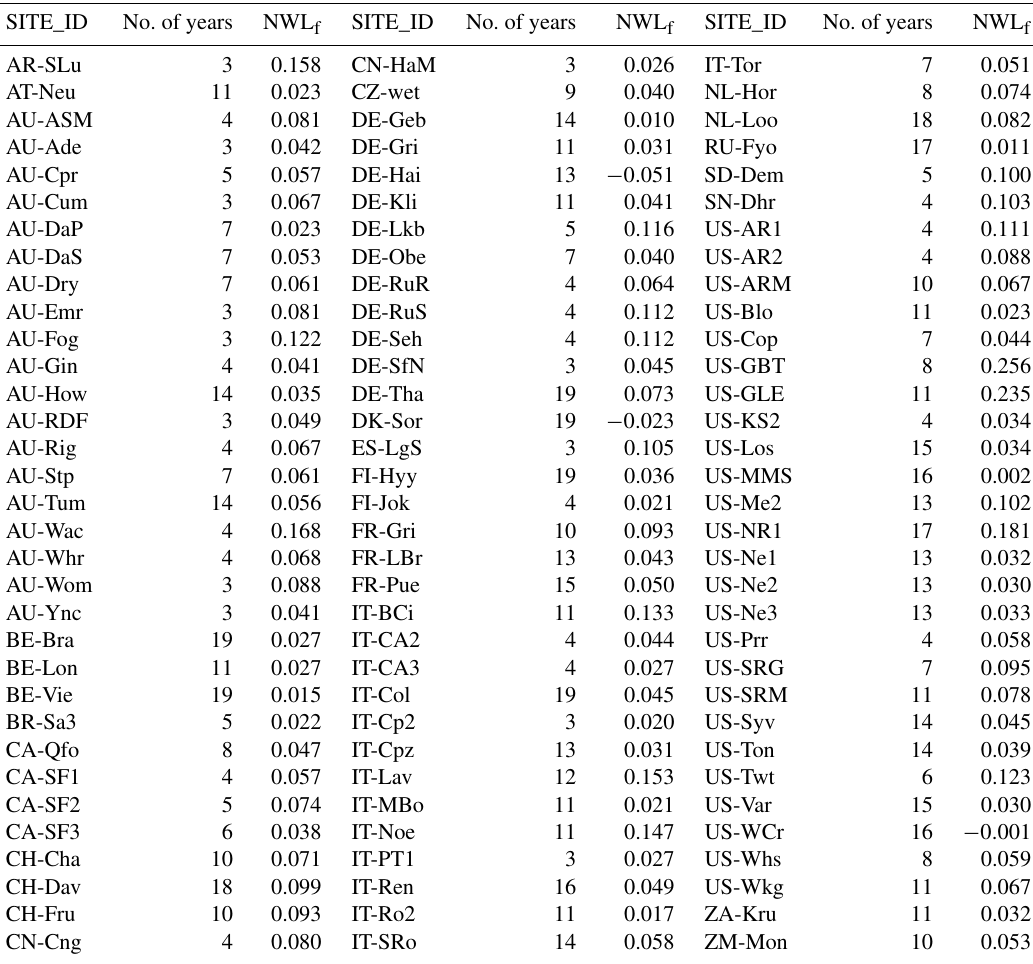
Table A1. FLUXNET sites from the FLUXNET2015 dataset employed for the analysis. Included sites provide energy-balance-corrected measurements of latent heat flux during at least 3 years. The FLUXNET2015 “SITE_ID” is indicated here, whereas a full description of each site is available at https://fluxnet.fluxdata.org/sites/site-list-and-pages/ (last access: 13 February 2020). Additionally, the number of years of data and the average energy-balance-corrected NWL f for each site are